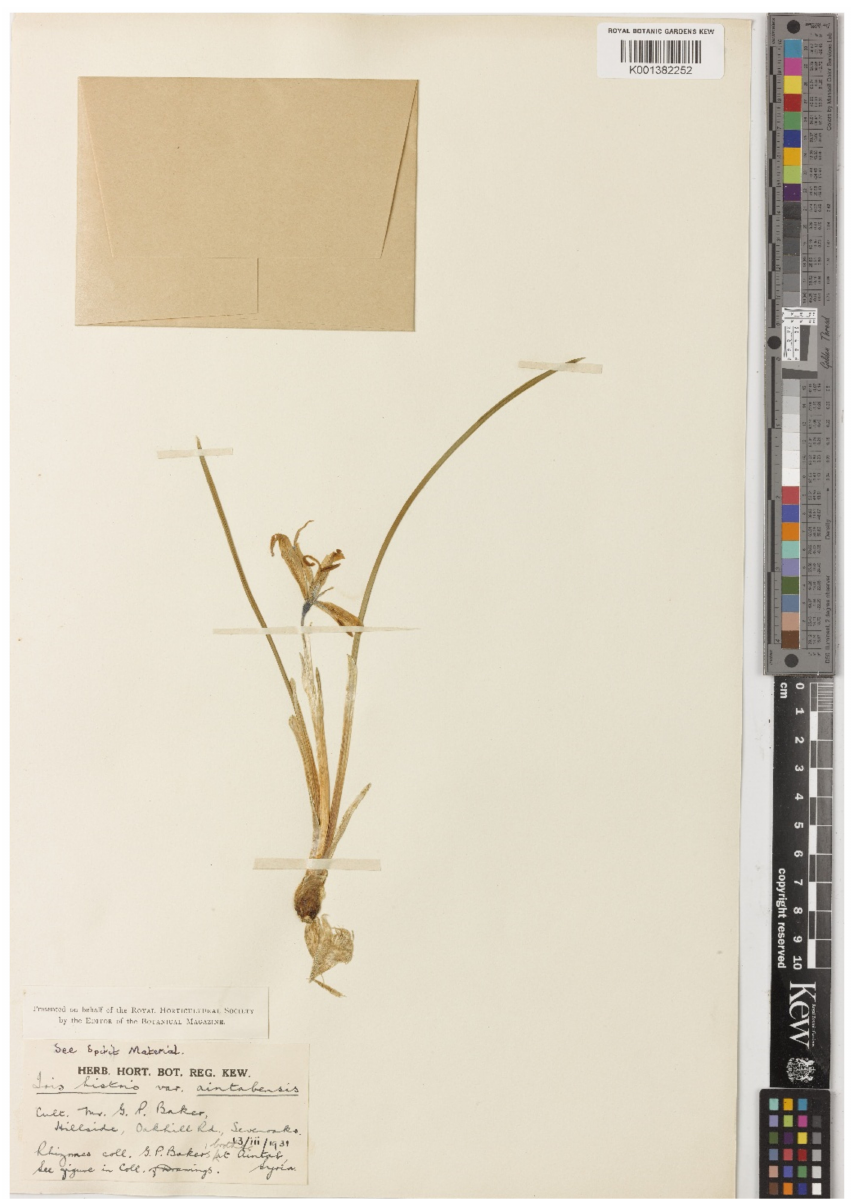
Figure 7. Lectotype of Iris histrio var. aintabensis (K001382252). Reproduced with the consent of the Royal Botanic Gardens, Kew. (16) Iris musulmanica Fomin, Vestn. Tiflissk. Bot. Sada 14: 46, 1909 ≡ I. spuria subsp. musulmanica (Fomin) Takht. in Takhtajan & Fedorov, Fl. Erevana, ed. 2: